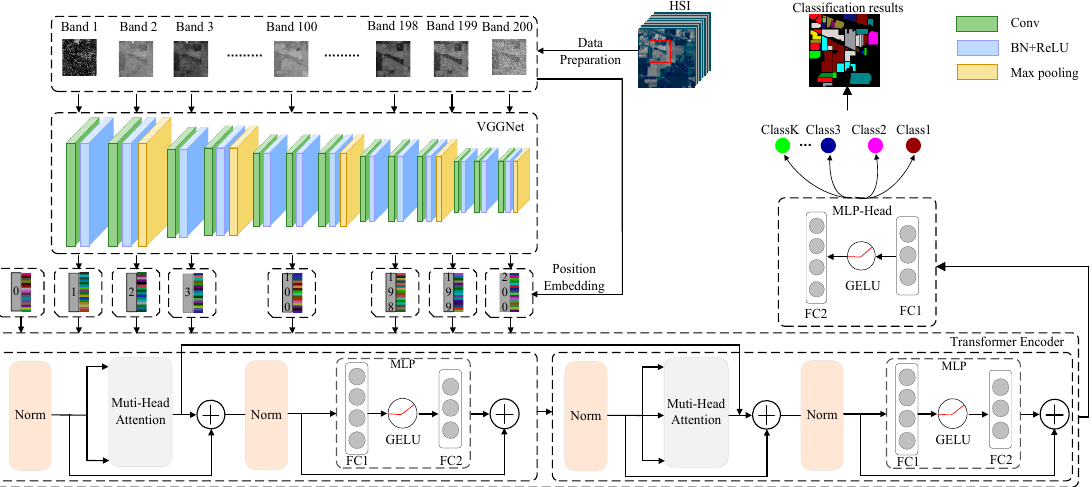
Figure 1. The framework of SST for HSI classification.